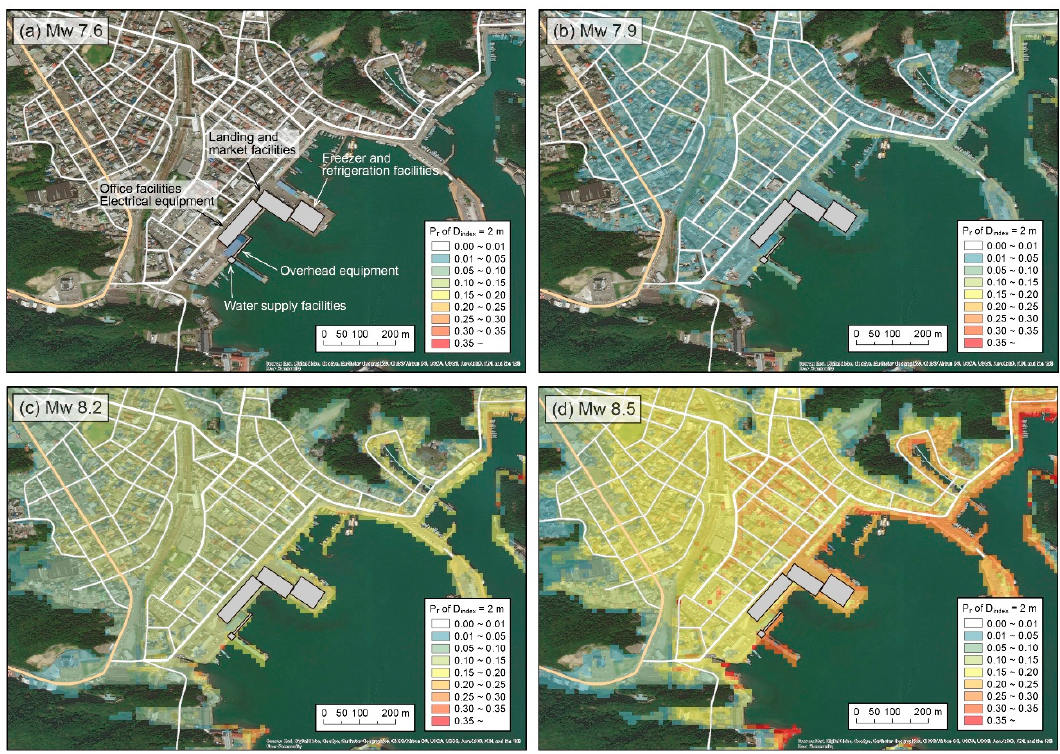
Figure 8. Probability distribution of tsunami inundation depth exceeding 2 m at Nachi-Katsu’ura Fishery Port. ( a ) Tsunami scenario for an Mw 7.6 cases, ( b ) Mw 7.9 cases, ( c ) Mw 8.2 cases, ( d ) Mw 8.5 cases.